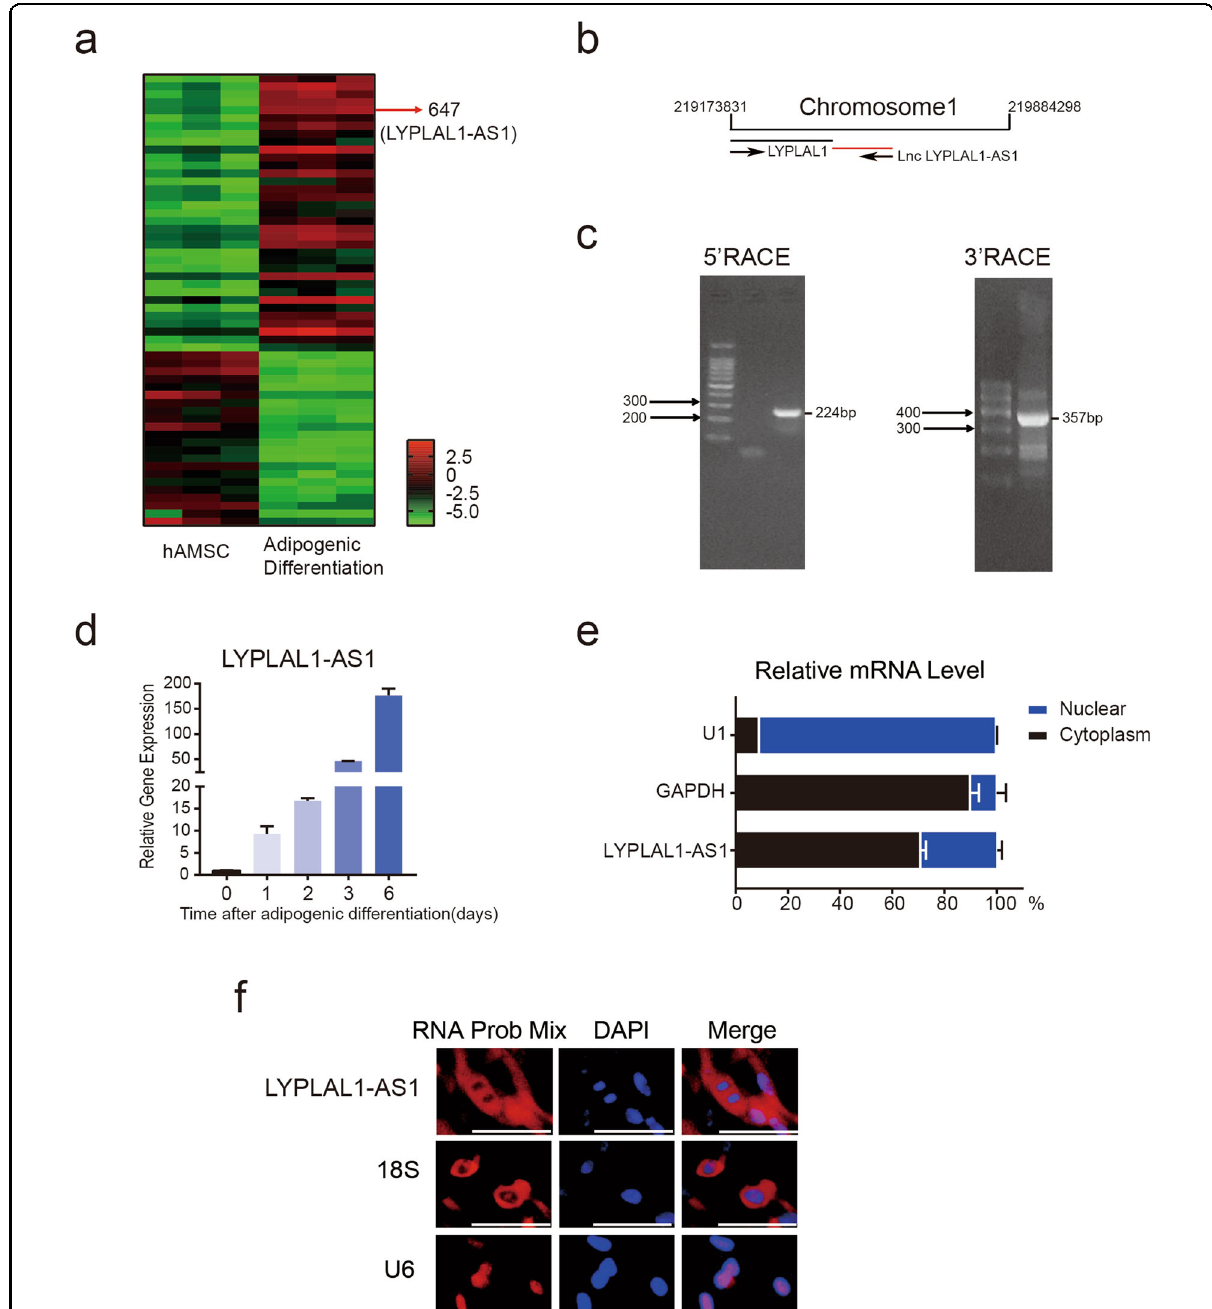
Fig. 1 Identi fi cation, validation, and characterization of LYPLAL1-AS1 during the adipogenic differentiation of hAMSCs. a Hierarchical clustering of signi fi cantly differentially expressed lncRNAs on day 3 after adipogenic differentiation as compared with matched undifferentiated hAMSCs from three donors. The red arrow indicates LYPLAL1-AS1. b Location of lncRNA LYPLAL1-AS1 on chromosome 1. c Rapid ampli fi cation of cDNA ends (RACE) for the 5 ′ end (left) and 3 ′ end (right) was performed to determine the full length of LYPLAL1-AS1. d qRT-PCR analysis veri fi ed the LYPLAL1-AS1 expression pro fi le at the indicated time points after hAMSC adipogenic differentiation. e Fractionation of LYPLAL1-AS1 in hAMSCs followed by qRT-PCR. GAPDH mRNA served as a cytoplasmic control. U1 mRNA served as a nuclear control. f RNA fl uorescence in situ hybridization (FISH) assay for LYPLAL1-AS1 in hAMSCs. 18S was the cytoplasmic mRNA control. U6 was the nuclear RNA control. The quantitative data were normalized to GAPDH , n = 3; data are shown as the mean ± SD; scale bars: 50